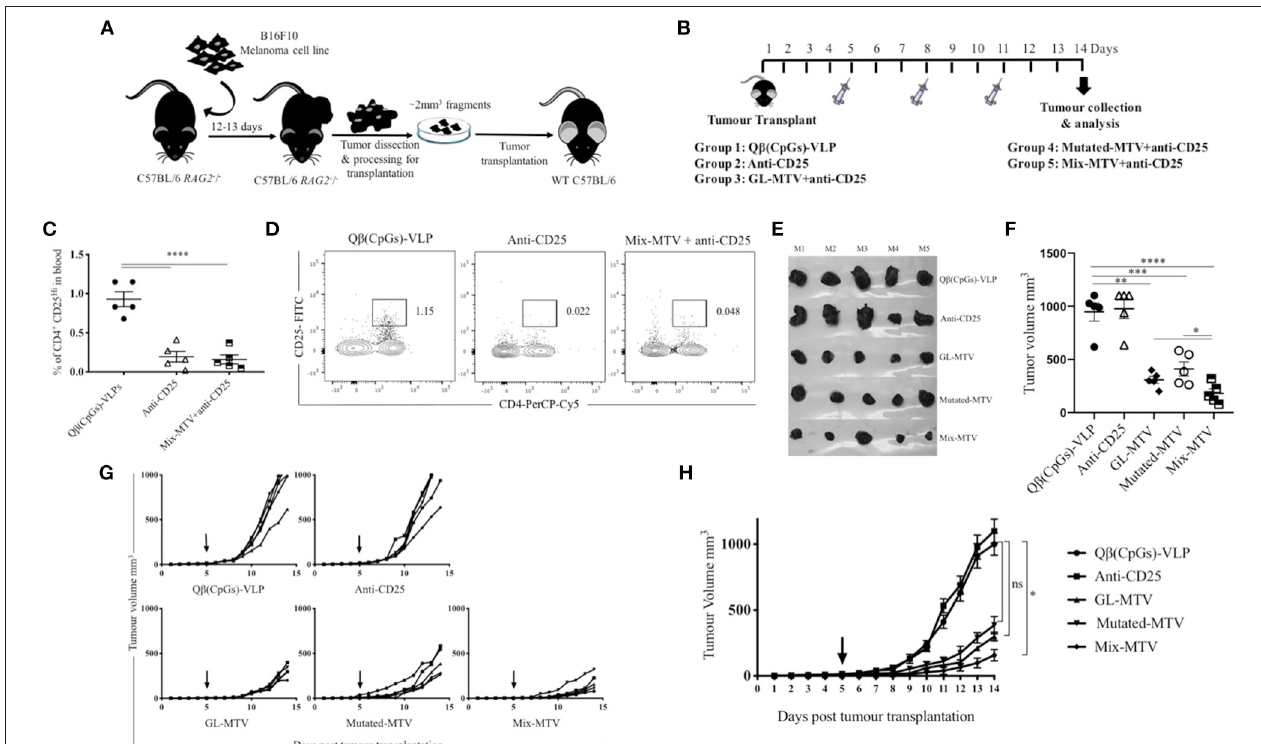
FIGURE 5 | Multi-target VLP-based vaccine using Cu-free click chemistry could significantly hinder the progression of the aggressive transplanted B16F10 tumor. (A) A sketch of the challenging therapeutic murine melanoma model based on injecting ∼ 1 × 10 6 B16F10 melanoma cell line into the flank of C57BL/6 RAG2 − / − mice. Twelve to thirteen days later the growing tumors are collected and processed for transplantation of ∼ 2 mm 3 into the flank of C57BL/6 WT mice. (B) Vaccination scheme of five groups: Q β (CpGs)-VLPs, anti-CD25, germline-multi target vaccine (GL-MTV), Mutated-MTV, and Mix-MTV GL-MTV. (C) Representative percentage of CD4 + CD25 Hi in the periphery of the groups vaccinated with Q β (CpGs)-VLPs, anti-CD25, and Mix-MTV + anti-CD25 on day 6 post-tumor transplantation. (D) Representative FACS plots showing the percentage of CD4 + CD25 Hi in periphery of the groups vaccinated with Q β (CpGs)-VLPs, anti-CD25, and Mix-MTV + anti-CD25 on day 6 post-tumor transplantation. (E) Photographic images of s.c. B16F10 tumors on day 14 post-tumor transplantation. (F) Tumor volume mm 3 (means ± SEM) measured on day 14 post-tumor transplantation for the groups vaccinated with Q β (CpGs)-VLPs, anti-CD25, GL-MTV, Mutated-MTV and Mix-MTV, each dot represents a tumor. Statistical analysis by Student’s t -test. (G) Individual tumor growth curves of s.c. B16F10 melanoma of the designated groups. (H) Combined tumor growth curves of the designated groups, arrows indicate start of treatment. Statistical analysis by AUC. The groups of GL-MTV, Mutated-MTV, and Mix-MTL were combined with anti-CD25mAb in all experiments. ( n = 5 ) mice per group, one representative of 3 similar experiments is shown. * P < 0.05 ; ** P < 0.01 ; *** P < 0.001 ; **** P <